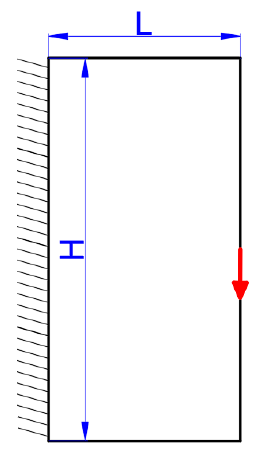
Figure 17. The short cantilever beam.